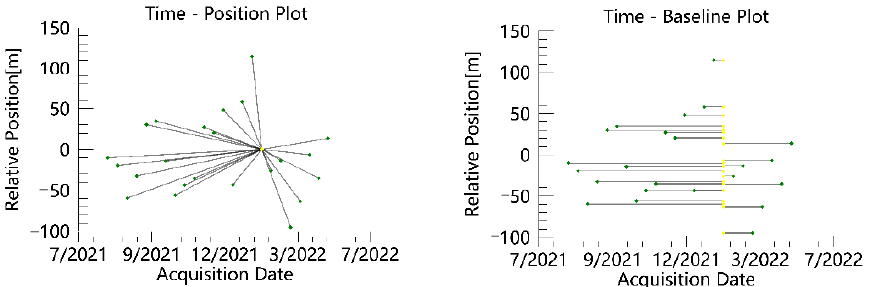
Figure 12. Time Baseline and Common Main Image Selection (green—valid data pairs; yellow—super main image).